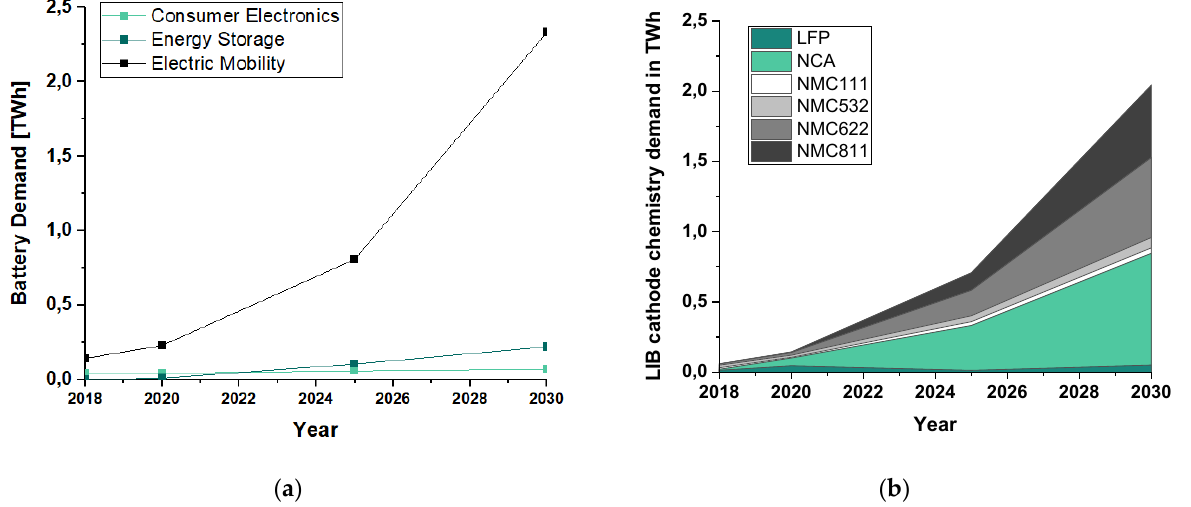
Figure 1. Information about the current and future development of the battery market with a special focus on LIB: ( a ) global battery demand by application in TWh for the year 2030 (data in this figure are from WEF base case [14]); ( b ) outlook of different LIB cathode chemistries until 2030 in TWh (data in this figure are from [15,16]—the detailed calculation can be reviewed in Appendix A). As seen in Figure 1, the forecasts for the LIB active materials show a wide variation.